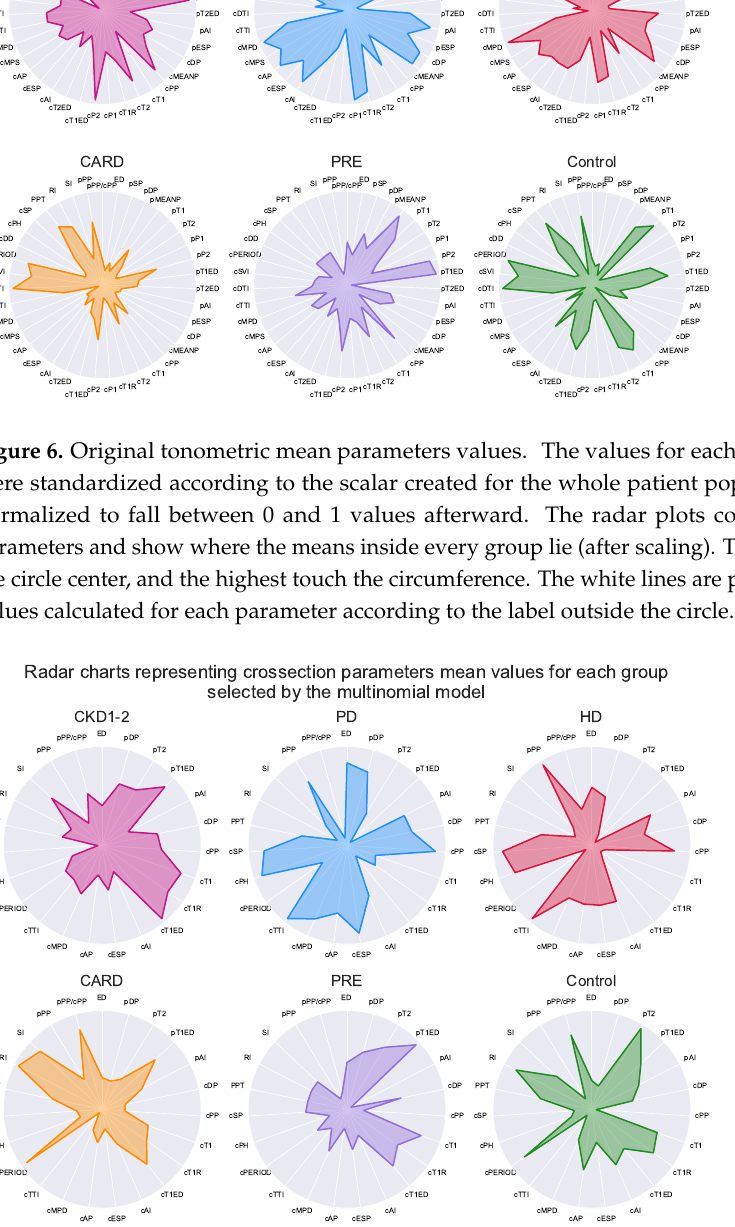
Figure 7. Selected tonometric mean parameters values. The values for each individual parameter were standardized according to the scalar created for the whole patient population (n = 252) and normalized to fall between 0 and 1 values afterward. The radar plots consist of 23 tonometry parameters and show where the means inside every group lie (after scaling). The lowest values are in the circle center, and the highest touch the circumference. The white lines are provided to easily track values calculated for each parameter according to the label outside the